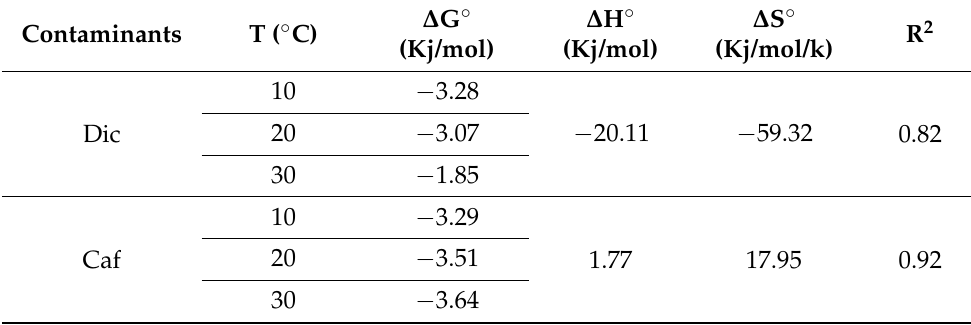
Figure 11. Plot of ln(Kc) versus temperature (1/T) for thermodynamic parameter calculation for the adsorption of Dic ( a ) and Caf ( b ) on AC based on argan nutshells. Table 7. Thermodynamic parameters relating to the adsorption of contaminants (Dic and Caf) on activated carbon based on argan nutshells.